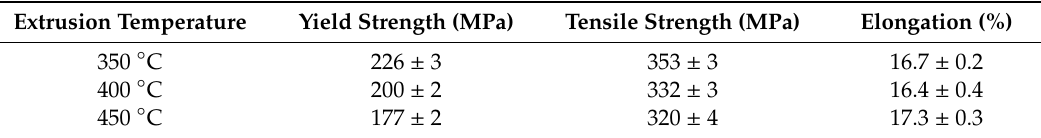
Table 1. Mechanical properties of the extruded sheets fabricated by low-speed